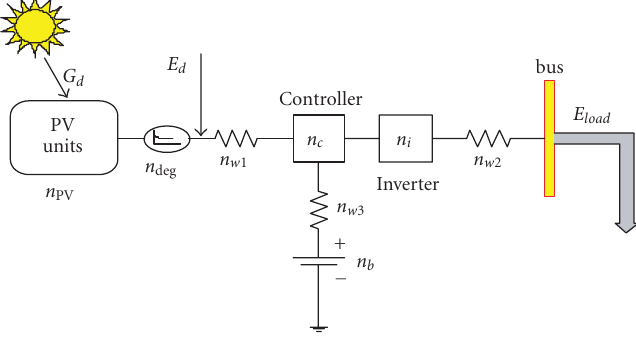
Figure 4: Schematic representation of a stand-alone PV system. n PV : e ffi cient factor of PV units, n w 1 : line e ffi cient factor between PV- converter, n w 2 : line e ffi cient factor between inverter-load, n i : e ffi cient factor of inverter, n c : e ffi cient factor of converter, n w 3 : line e ffi cient factor between converter-batteries, n b : e ffi cient factor of batteries, n deg : degradation coe ffi cient of PV